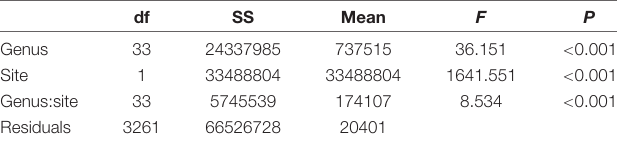
TABLE 5 | Two-way ANOVA results for comparison of mean bathymetric distribution by genus and biogeographic regions.